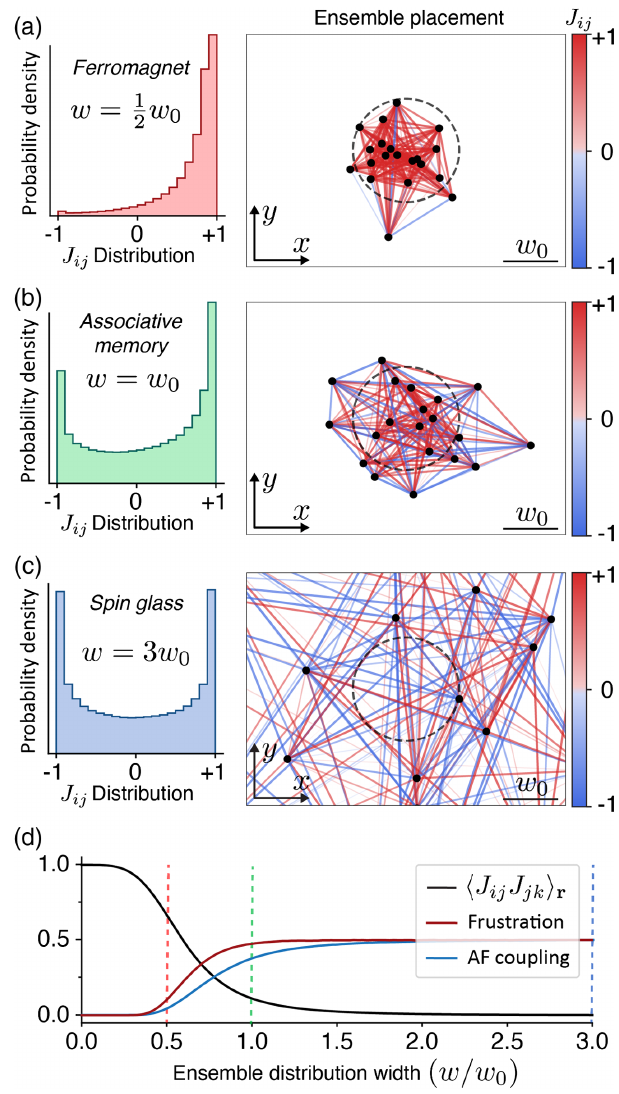
FIG. 4. Confocal cavity connectivities. Distribution of normal- ized J couplings shown for widths (a) w ¼ w 0 = 2 , (b) w ¼ w 0 , ij and (c) w ¼ 4 w 0 . Representative J connectivity graphs are ij shown to the right, with red (blue) links indicating ferromagnetic J > 0 (antiferromagnetic J < 0 ) coupling. The radius w 0 is the ij ij Gaussian width of the TEM 00 mode in the transverse plane and is indicated by the dashed circle. (The modes of a multimode cavity extend far beyond the characteristic length scale w 0 .) (d) Stat- istical properties of the J versus w . The correlation function in ij Eq. (8) between different J (black line) shows that they become ij uncorrelated at large w . The probability of generating frustration between three randomly chosen spins (red line) and the proba- bility of generating an antiferromagnetic coupling between two randomly chosen spins (blue line) are also plotted. The dashed lines correspond to the widths used in (a) –